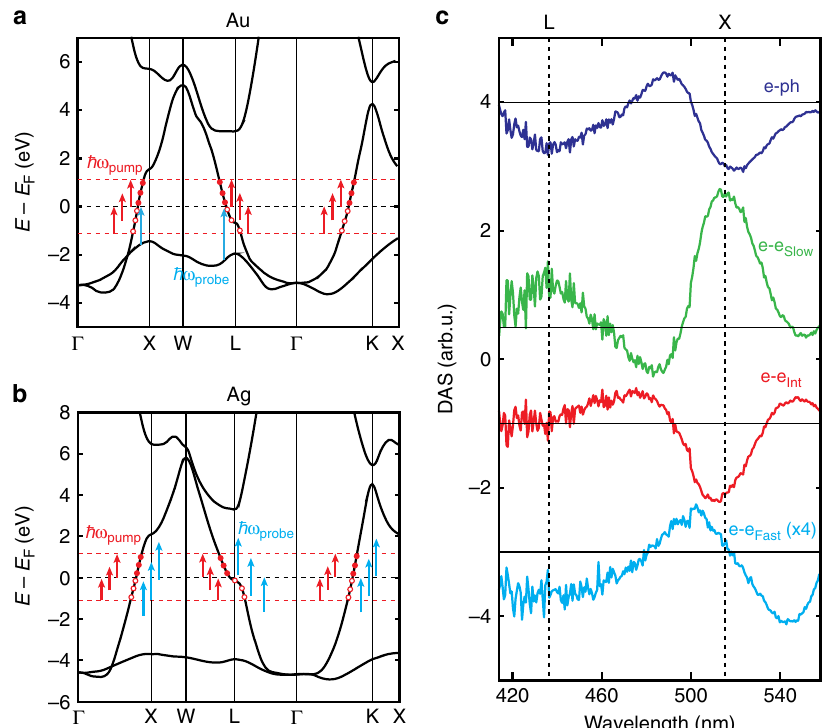
Fig. 8 Resolving carrier localization within the Au band structure from IB transitions. a Band structure of Au exhibiting three sp -band crossings of the Fermi level near the X, L, and K symmetry points of the Brillouin zone. The intraband pump (red arrows) at the gap resonance promotes nonthermal carrier distributions (circles) in the sp -bands crossing the Fermi surface. The IB probe wavelengths (blue arrows) only monitor transitions from the upper d -band to crossings of the Fermi surface near the X and L points. b Band structure of Ag exhibiting strong similarities to that of Au. IB transitions in Ag occur at energies higher than ~4 eV, thus the probe (blue arrows) monitors only intraband transitions in the measurement range. The red arrows again refer to the intraband pump photons at the gap plasmon resonance. The data for ( a , b ) were taken from literature 42, 43 , and only the highest energy d -band and fi rst two sp -bands are shown for clarity. c Decay-associated spectra (DAS) in the IB region of the 8 nm Al 2 O 3 sample pumped at ~130 μ J cm − 2 . Each DAS is offset for clarity. The fast nonthermal carriers redshift the X transition, indicative of carriers residing below the Fermi level near the X point, and also exhibit a bleach at the L transition. Intermediate nonthermal carriers appear to be localized solely at the X point where they induce a bleach of the absorbance. Slow nonthermal carriers yield perturbations to transitions near both X and L points. IB transitions at the K point occur at much higher energies, and thus are not resolved in the measurement range